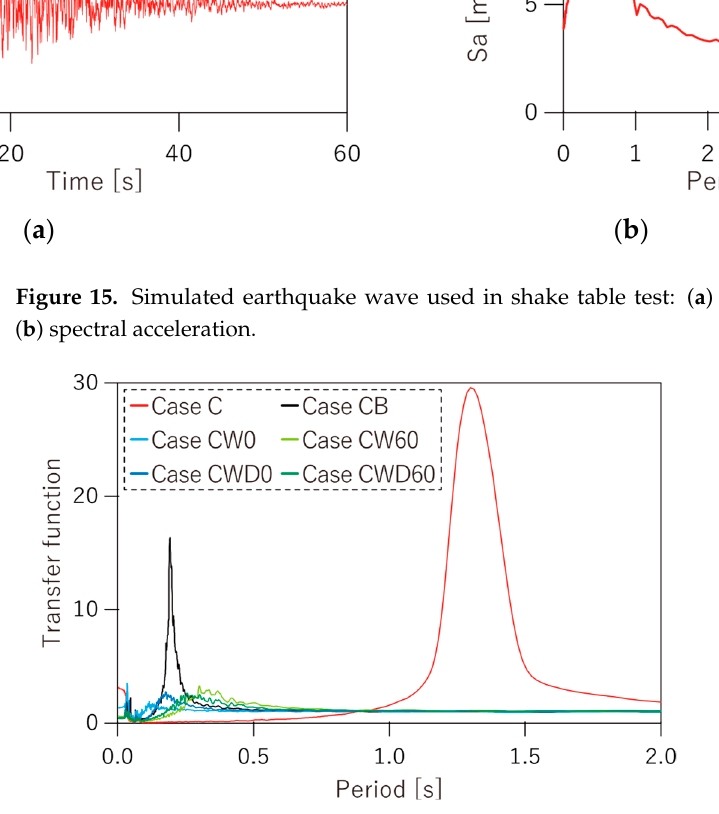
Figure 15. Simulated earthquake wave used in shake table test: ( a ) Acceleration time histories; ( b ) spectral acceleration.